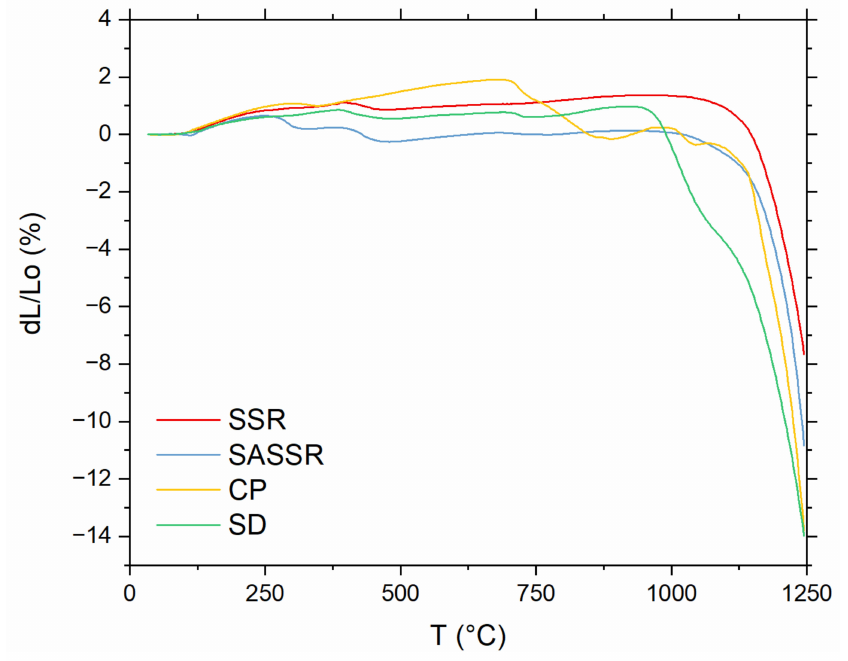
Figure 6. Linear shrinkage measured for green pellets of all four powders (red—SSR; blue—SASSR; yellow—SD; green—CP) between 30 and 1250 ◦